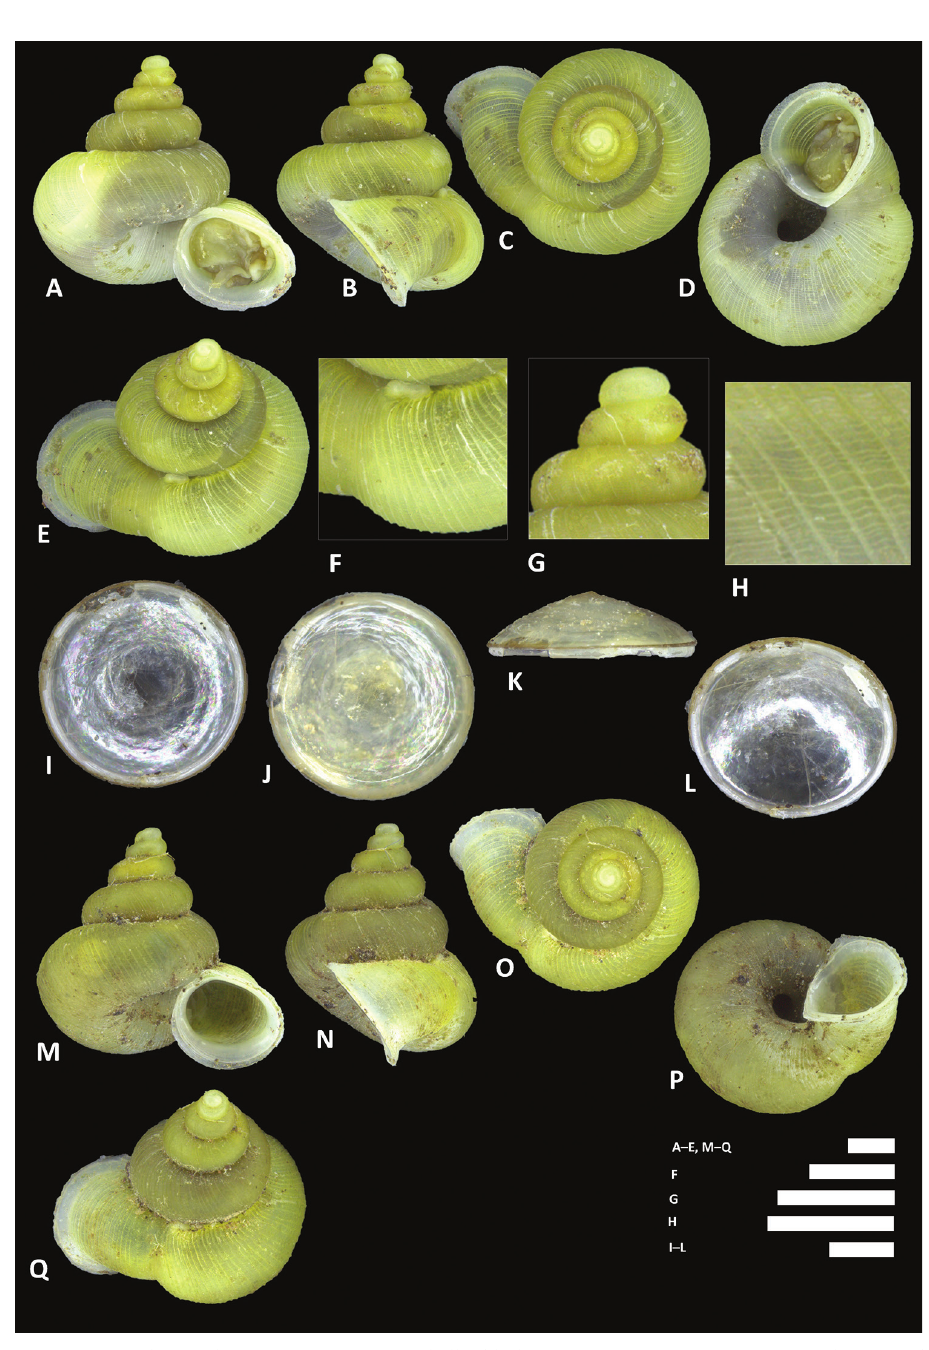
Figure 22. Alycaeus kurauensis sp. n. A–E Shell of holotype, BOR/MOL 12967 F–H Close up of shell of holotype, BOR/MOL 12967 I–L Operculum of paratype, BOR/MOL 6851 M–Q Shell of paratype, BOR/MOL 6851. Scale bars: A–E, F, G, M–Q 1 mm; H, I–L 0.5 mm. All photographs by Junn Kitt